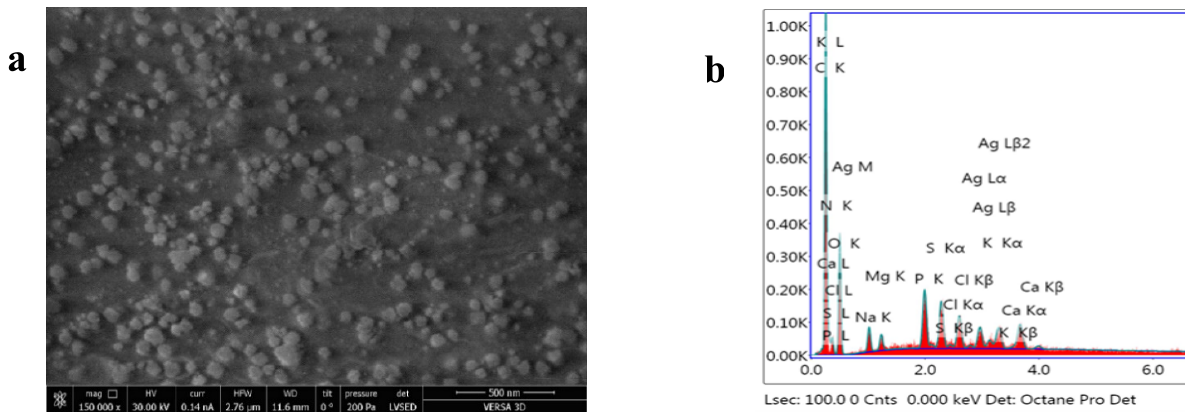
Figure 2. AgNPs-Spirulina (protein fraction) a . SEM; b . EDAX.